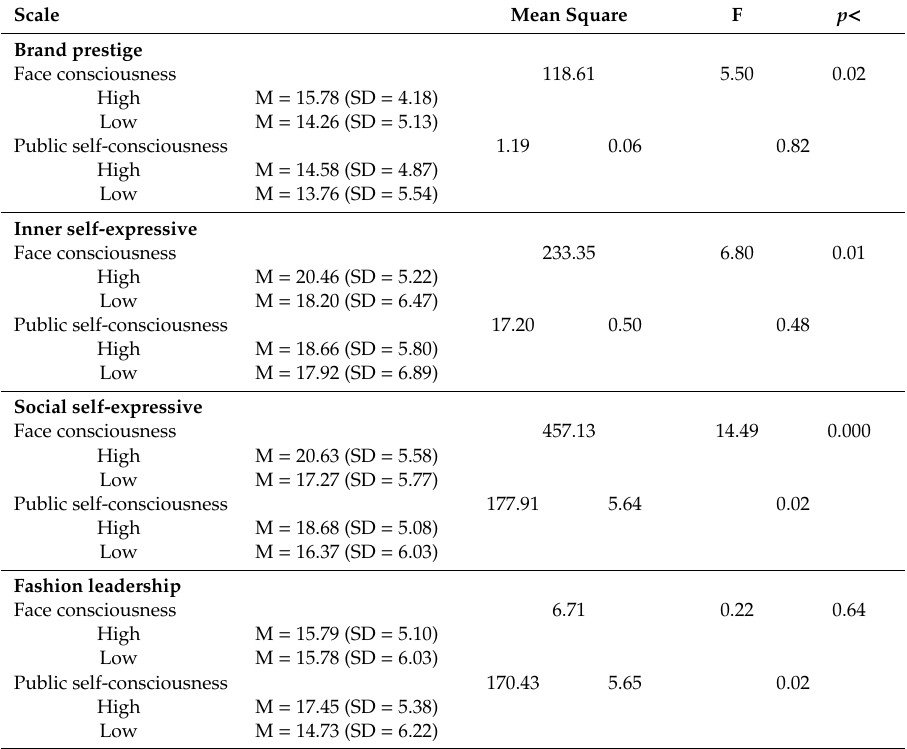
Table 2. ANOVA results for dependent variables by face consciousness and public self-consciousness.